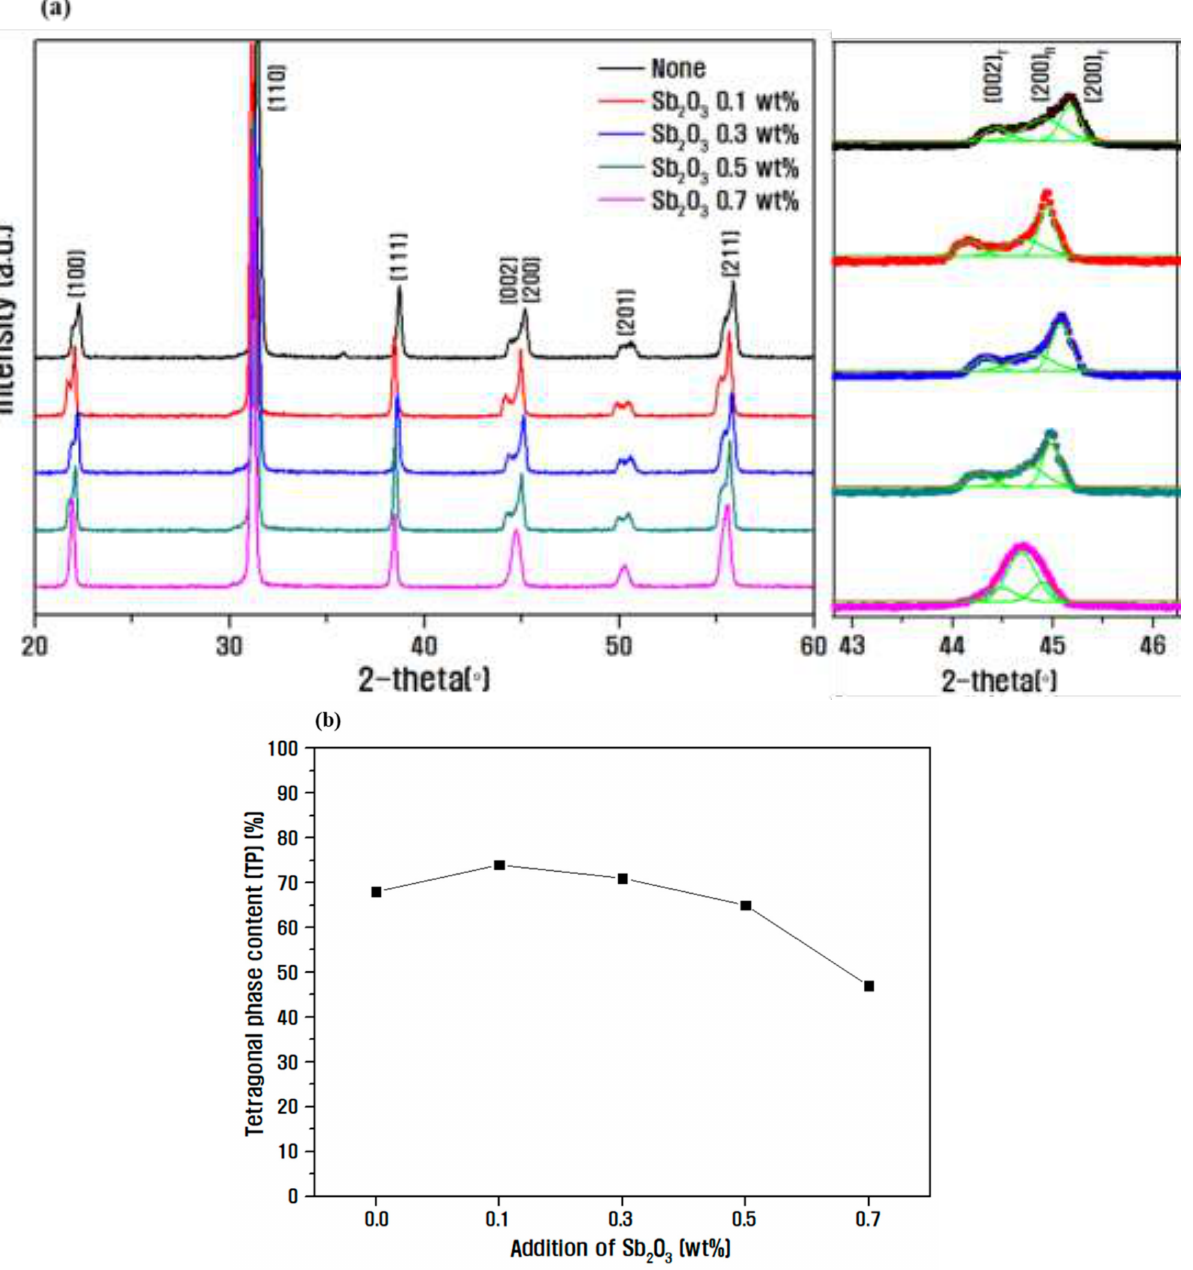
Figure 3. ( a ) Results of X-ray diffraction pattern analysis with different Sb 2 O 3 doping amounts